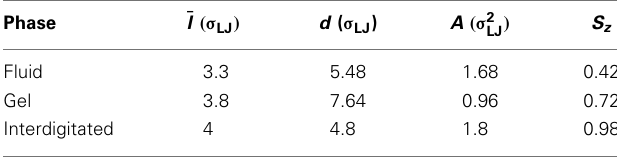
Table 2 | Characteristic parameters of lipid